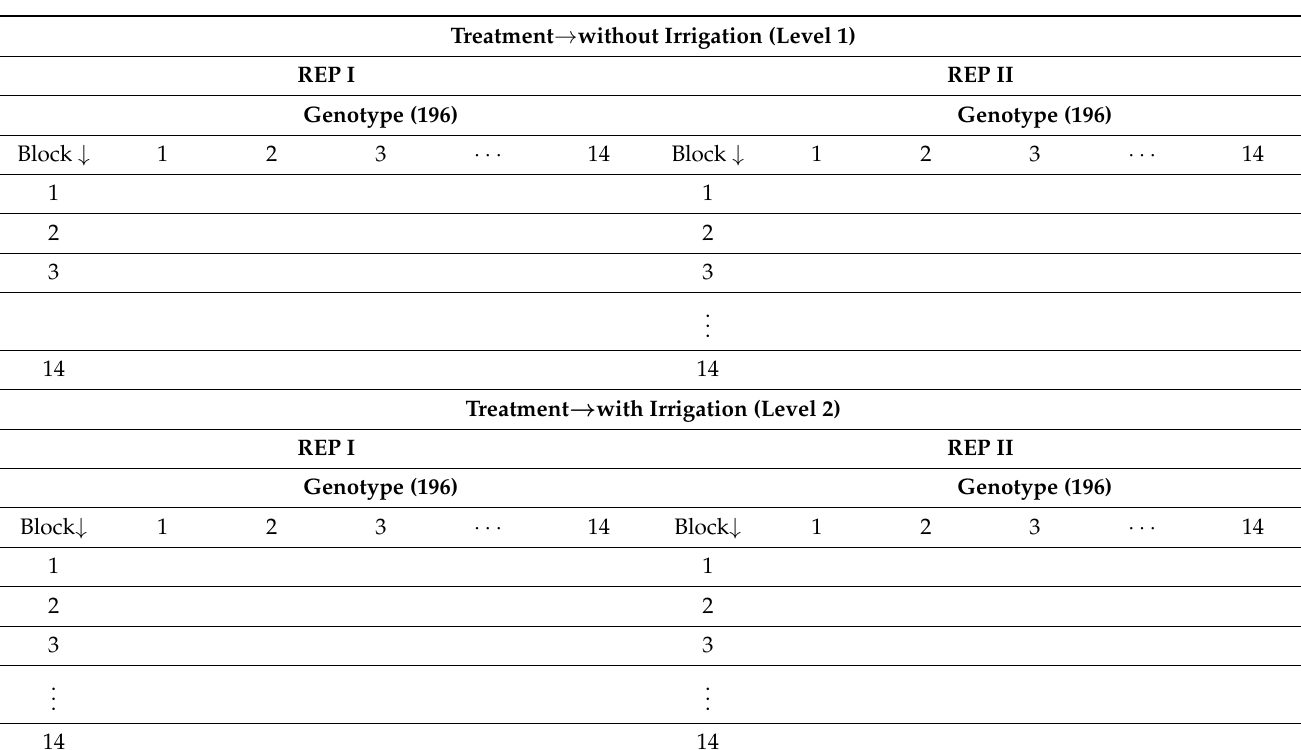
Table 1. Lattice Square Design Layout of the